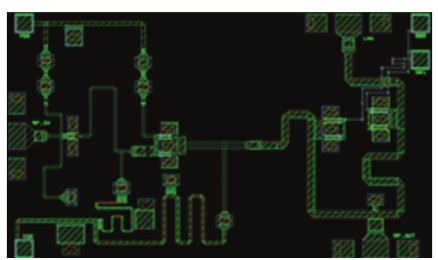
Figure 4: Layout of the proposed MFPA